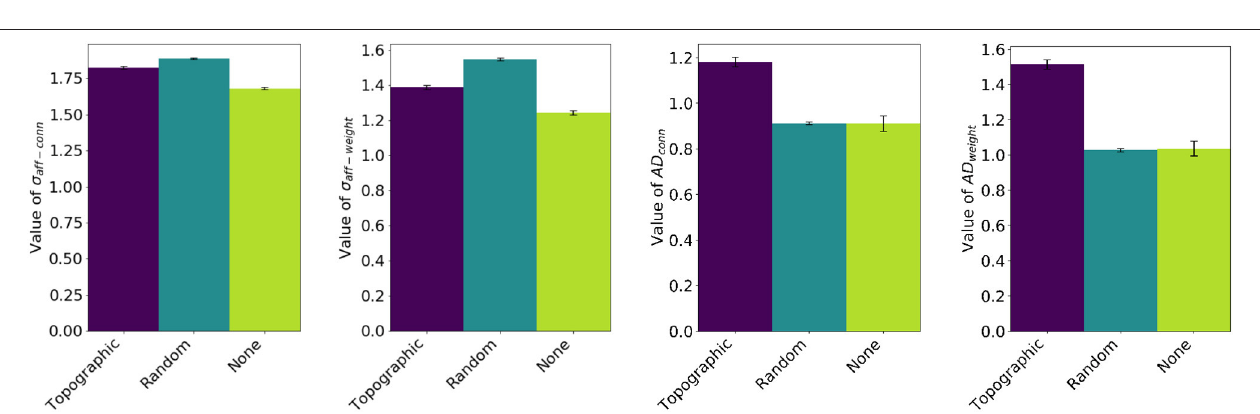
FIGURE 7 | Comparison of final values for σ aff and AD in the case where input correlations are absent (Case 3). Three types of networks have each been run 10 times (to generate the standard error of the mean), each starting with a different initial connectivity: an initial rough topographic mapping as in the previous experiments, a random 10% connectivity (5% feedforward, 5% lateral) and almost no connectivity (one-to-one connectivity used due to software limitations).